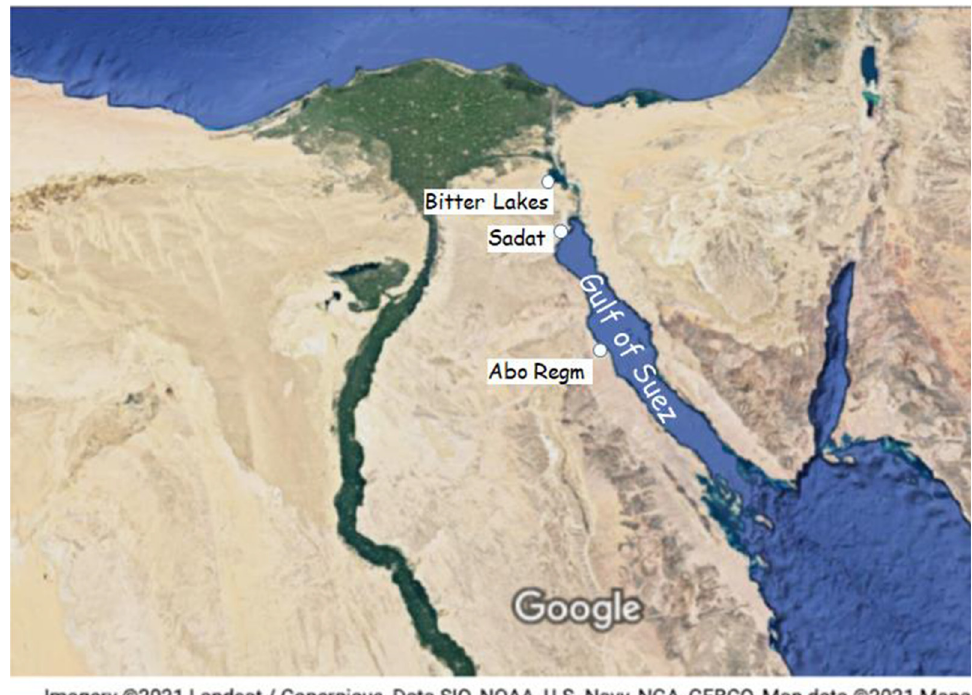
Fig. 2. Sampling locations, shown as white points, for Penaeus semisulcatus from Bitter Lakes (N3026 0 61.7 00 , E32 44 0 98.6 00 ) and Gulf of Suez [Sadat (N2945 0 74 00 , E3230 0 17) and Abo Regm (N2843 0 35 00 , E3251 0 13)] at the North-Western Red Sea, Egypt. Photo from GoogleMaps TM (map credits are shown below the